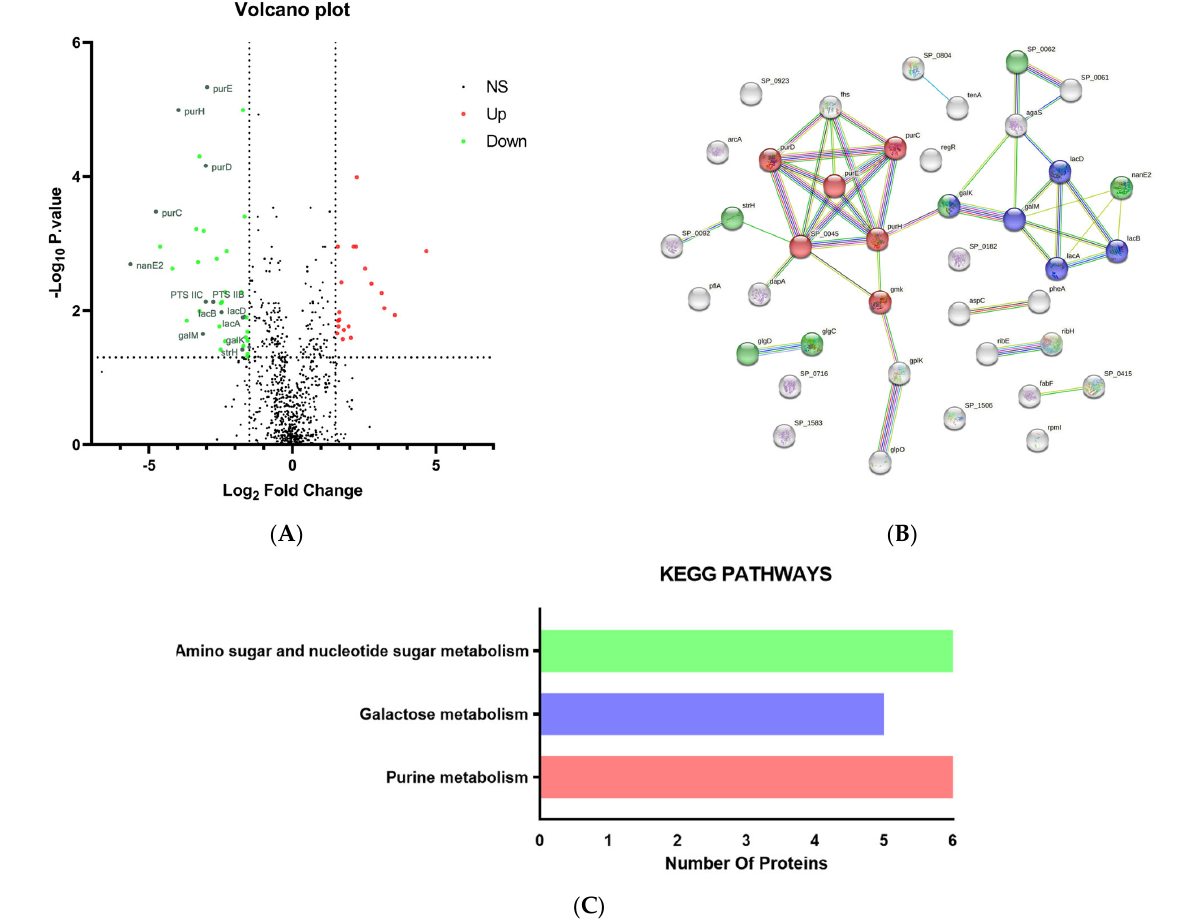
Figure 2. Proteomics analysis of PRSP F3983 treated by ES compared with control. ( A ) Volcano plot of the differently expressed proteins (DEPs) between control and treatment samples. ( B ) Network map of interactions among the down ‐ regulated DEPs. The strength of interaction is represented by the line thickness, and thicker lines represent interactions with higher confidence. Each network node represents a protein; each edge denotes protein–protein associations and disconnected nodes are hidden in the network. The green, blue, and red circle colors represent proteins enriched in amino sugar and nucleotide sugar metabolism, galactose metabolism, and purine metabolism, respectively. ( C ) The enriched KEGG pathway of the down ‐ regulated DEPs. The number of proteins included in the corresponding pathway is denoted with horizontal bars.